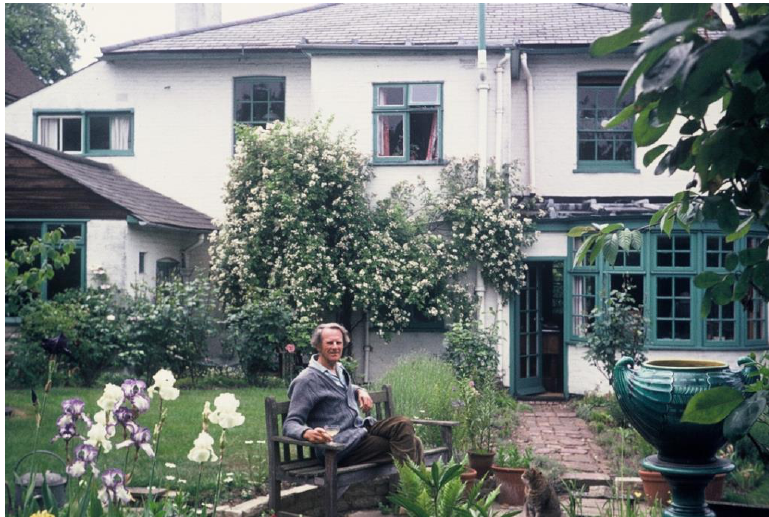
Figure 12. Max relaxing in the garden at Redhill. Gunnar Jungner visited him here in the 1960s.